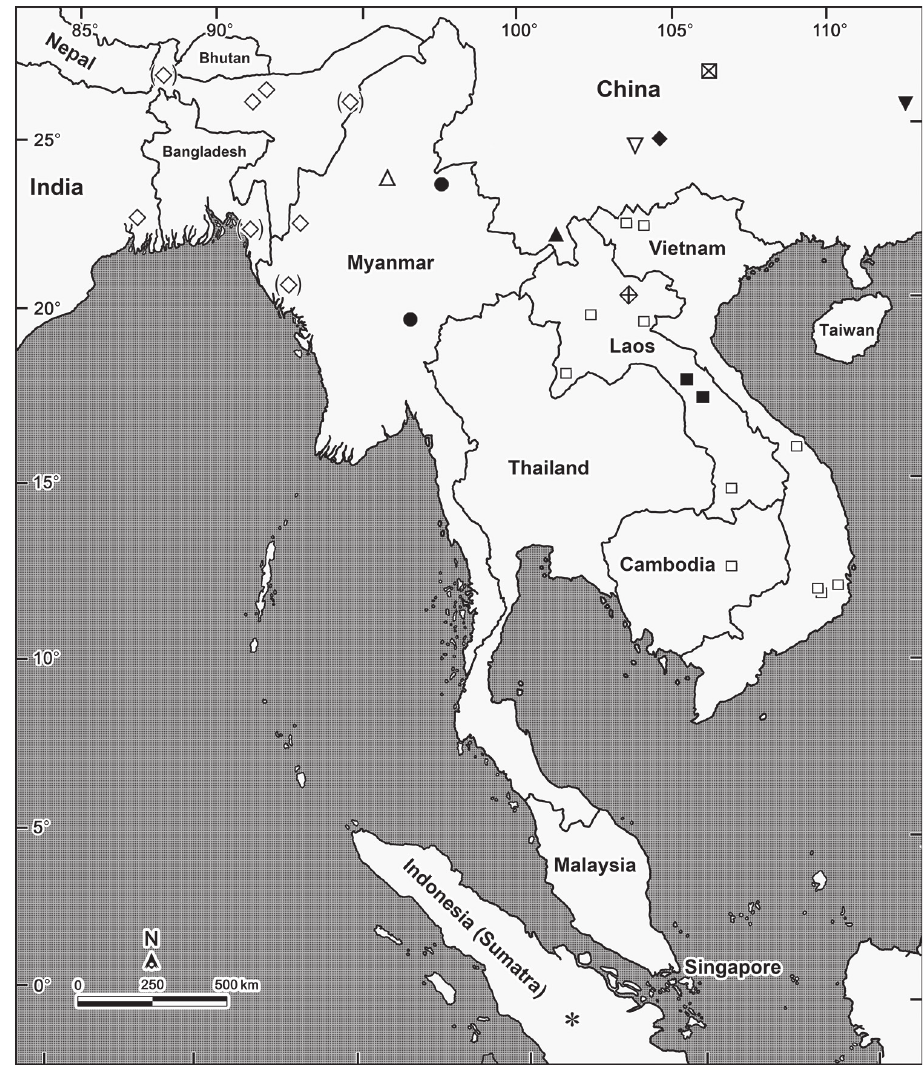
Figure 5. Distribution of 12 currently known species of Trichopeltis . Open diamonds: T. watsoni Pocock, 1895; crossed open square: T. latellai Golovatch, Geoffroy, Mauirès & VandenSpiegel, 2010; open trian- gle: T. doriae Pocock, 1895; filled circle: T. feae Pocock, 1895; inverted open triangle: T. intricatus Liu, Golovatch & Tian, 2017; filled diamond: T. bellus Liu, Golovatch & Tian, 2017; inverted filled triangle: T. reflexus Liu, Golovatch & Tian, 2017; filled triangle: T. sutchariti sp. n.; crossed open diamond: T. mu- ratovi Golovatch & VandenSpiegel, 2017; filled squares: T. cavernicola Golovatch, 2016; open squares: T. kometis (Attems, 1938); asterisk: T. bicolor (Pocock, 1984). > tibiae > coxae and postfemora (Fig. 2G); gonapophyses on ♂ coxae 2 small cones; neither adenostyles nor tarsal brushes present. Gonopod aperture transversely ovoid, caudal and lateral margins thin, only slightly elevated (Fig.